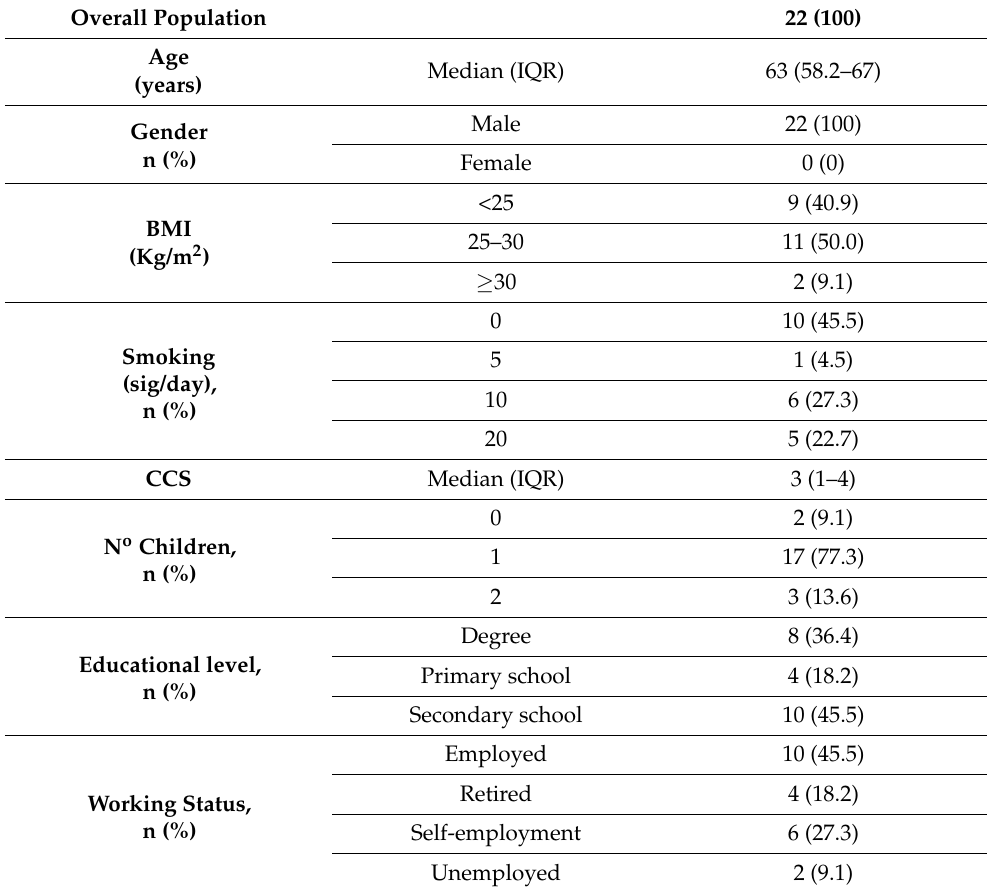
Table 1. Descriptive characteristics of 22 COVID-19